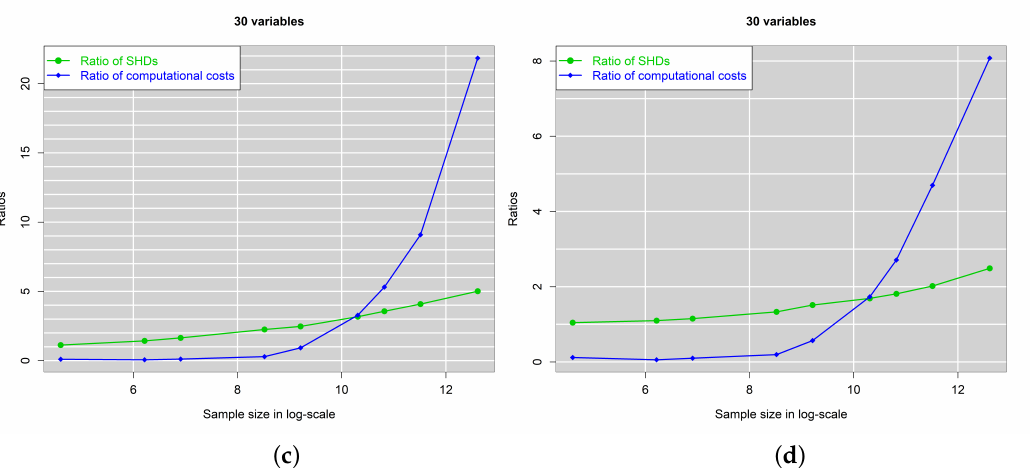
Figure 8. Ratios of SHD and computational cost against log of sample size for 20 and 30 dimensions with 3 neighbours and 5 neighbours on average. The ratios depict the errors and computational cost of the raw FEDHC relatively to the robustified FEDHC with 5% outliers. ( a , c ) 3 neighbours. ( b , d ) 5 neighbours.